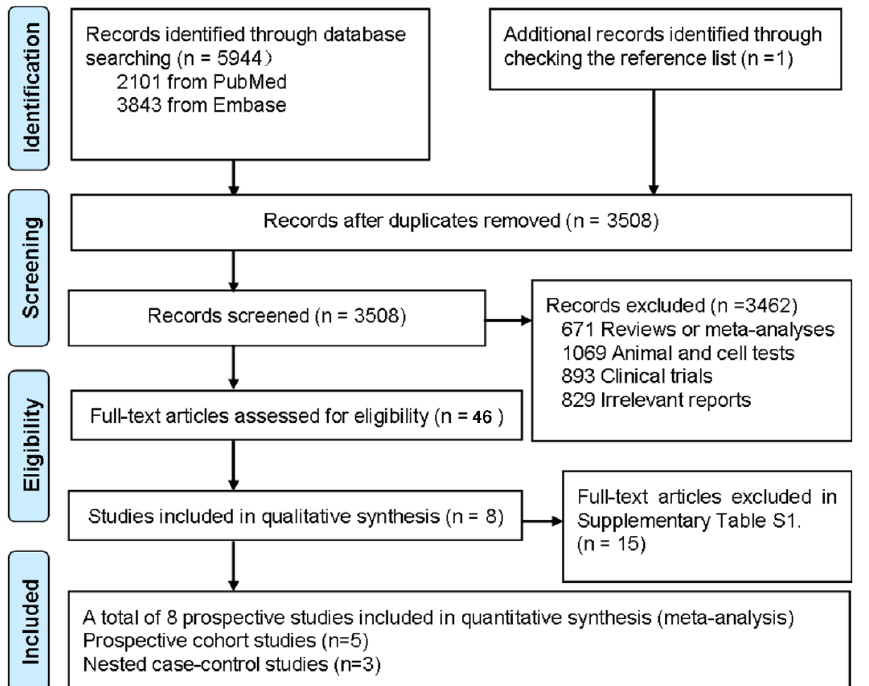
Figure 1. Preferred Reporting Items for Systematic Reviews and Meta-Analyses ( PRISMA ) Flow Diagram for included prospective cohort studies.